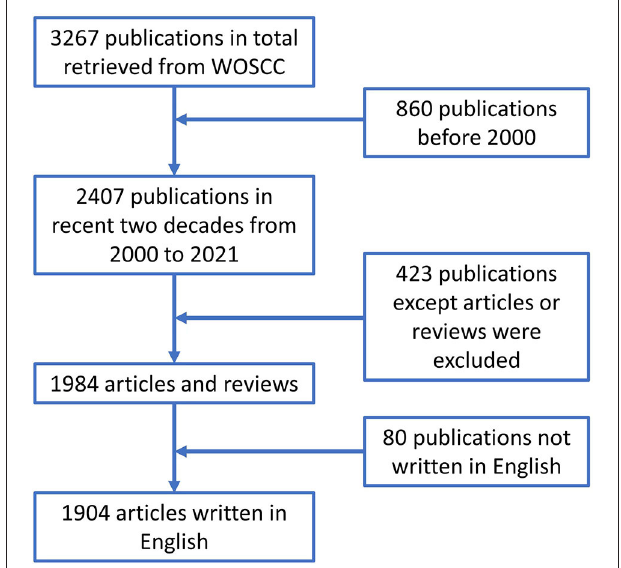
FIGURE 1 | Flow diagram of the inclusion